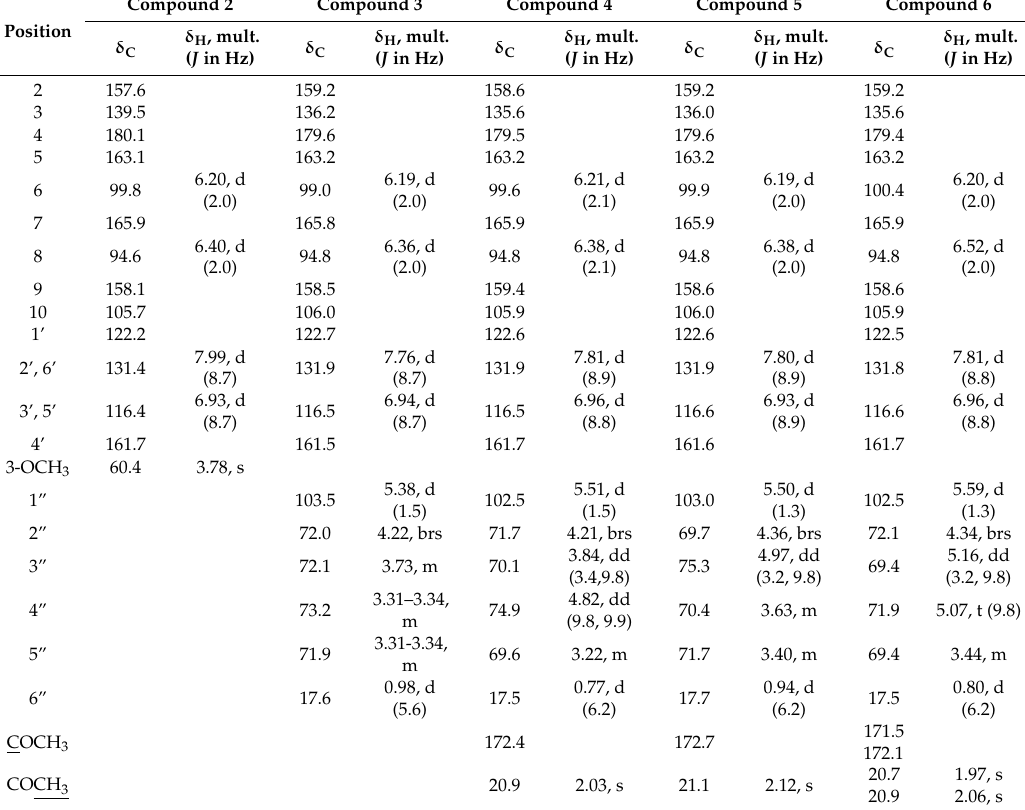
Table 2. NMR spectroscopic data of compounds 2 – 6 in CD 3